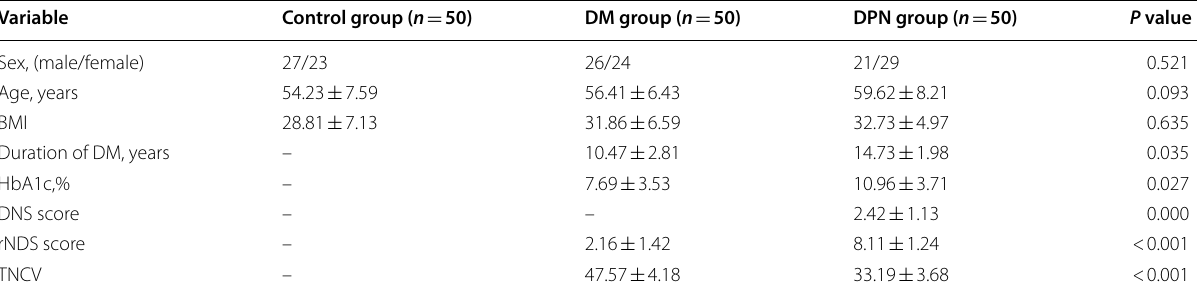
Table 1 Characteristics of the study groups